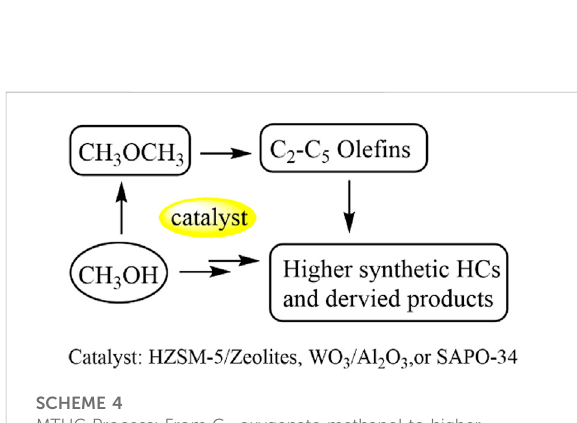
SCHEME 4 MTHC Process: From C 1 -oxygenate methanol to higher